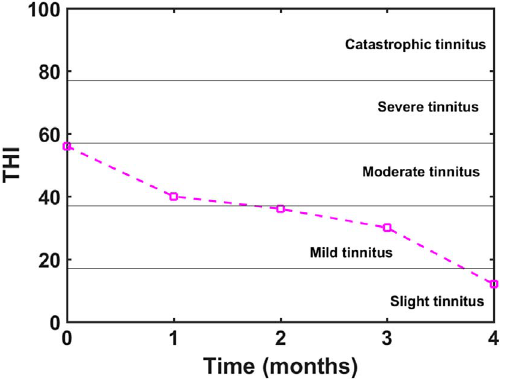
Figure 14. THI time progress of participant #3 along